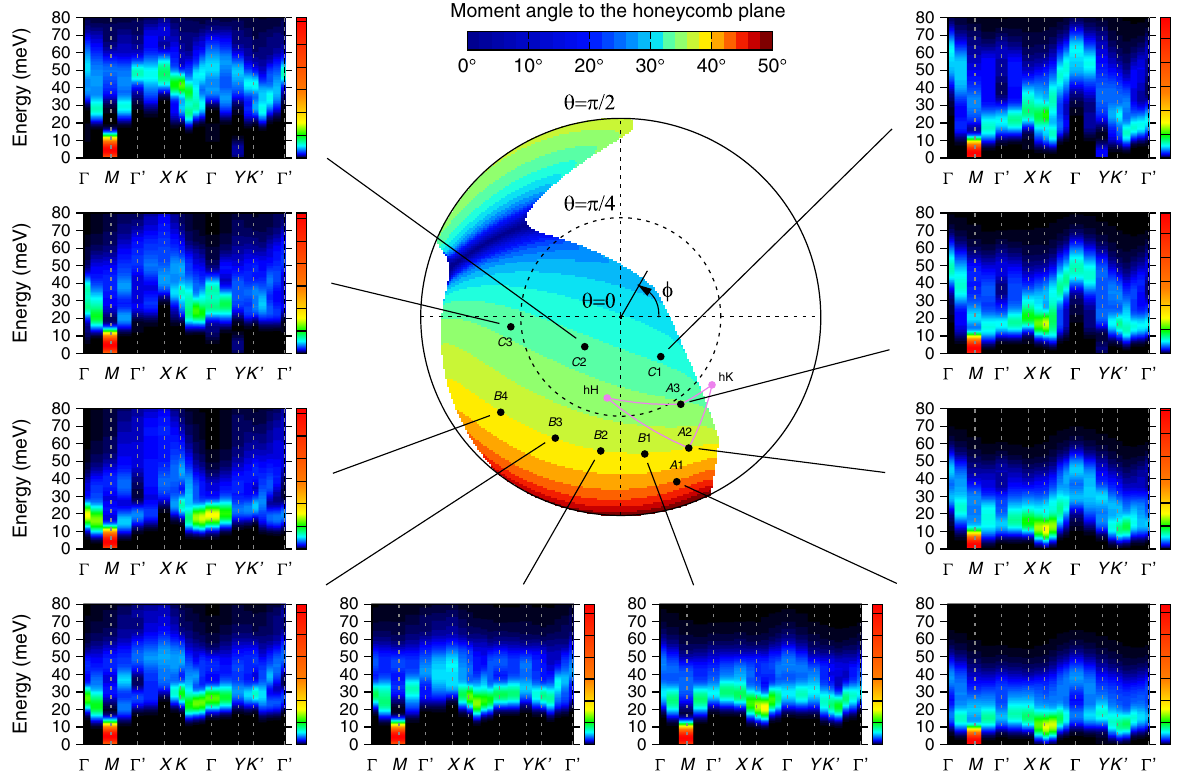
FIG. 3. Zigzag phase in the phase diagram of the extended Kitaev-Heisenberg model with the main interactions parametrized using the radial coordinate θ and the azimuth ϕ as J ¼ A sin θ cos ϕ , K ¼ A sin θ sin ϕ , Γ ¼ A cos θ , and the smaller interactions kept constant: Γ 0 ¼ − 0 . 1 A , J 0 . 05 A , and J 0 . 1 A . Here, A is the overall energy scale, which is irrelevant for the phase diagram but determines 2 ¼ 3 ¼ the characteristic energies of the magnetic excitations. The color indicates the angle of the zigzag-ordered moments to the honeycomb plane. The data are obtained using the exact-diagonalization-based method in Ref. [51]. Small panels around the phase diagram show, for selected parameter points, the theoretical RIXS intensity maps calculated by exact diagonalization of the extended Kitaev-